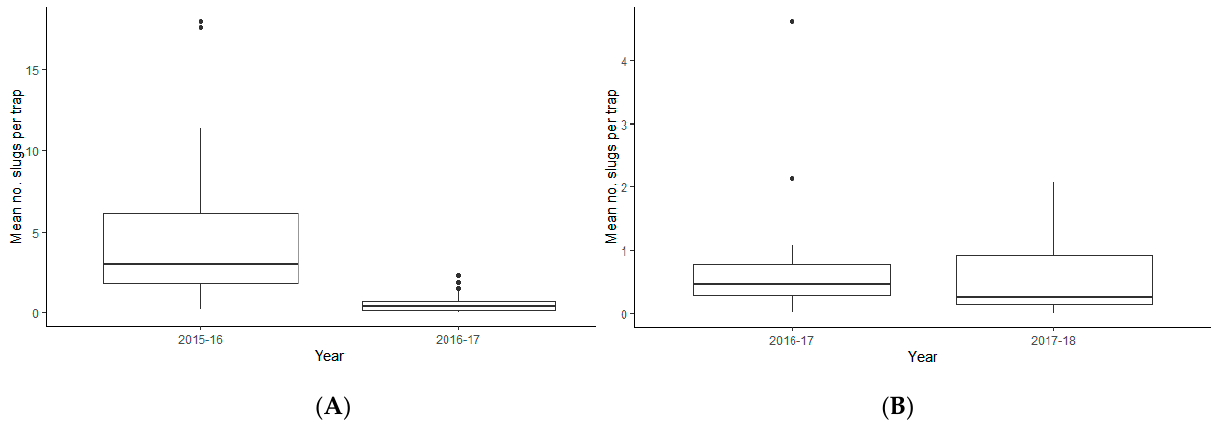
Figure 1. Variation in the number of slugs recorded (mean No. trap − 1 ) in successive seasons in a 10 × 10 grid of refuge traps, set within a rectangular 1ha plot in each field. ( A ) Fields assessed in both 2015–16 and 2016–17 (Shrops 2, Shrops 3, Shrops 4 and Shrops 5); ( B ) Fields assessed in both 2016–17 and 2017–18 (Shrops 2, Leic 1, Lancs 1). For details of crops sampled see Table 1. Horizontal line = median x ̄ slugs per trap; bottom and top of box indicate the 25th and 75th percentiles; whiskers = 1.5 x the interquartile range above or below the 25th or 75th percentiles; points are outliers. There was no significant effect of region ( Χ 2 = 3.14, d.f. = 2.80, p = 0.21)) or crop ( Χ 2 =